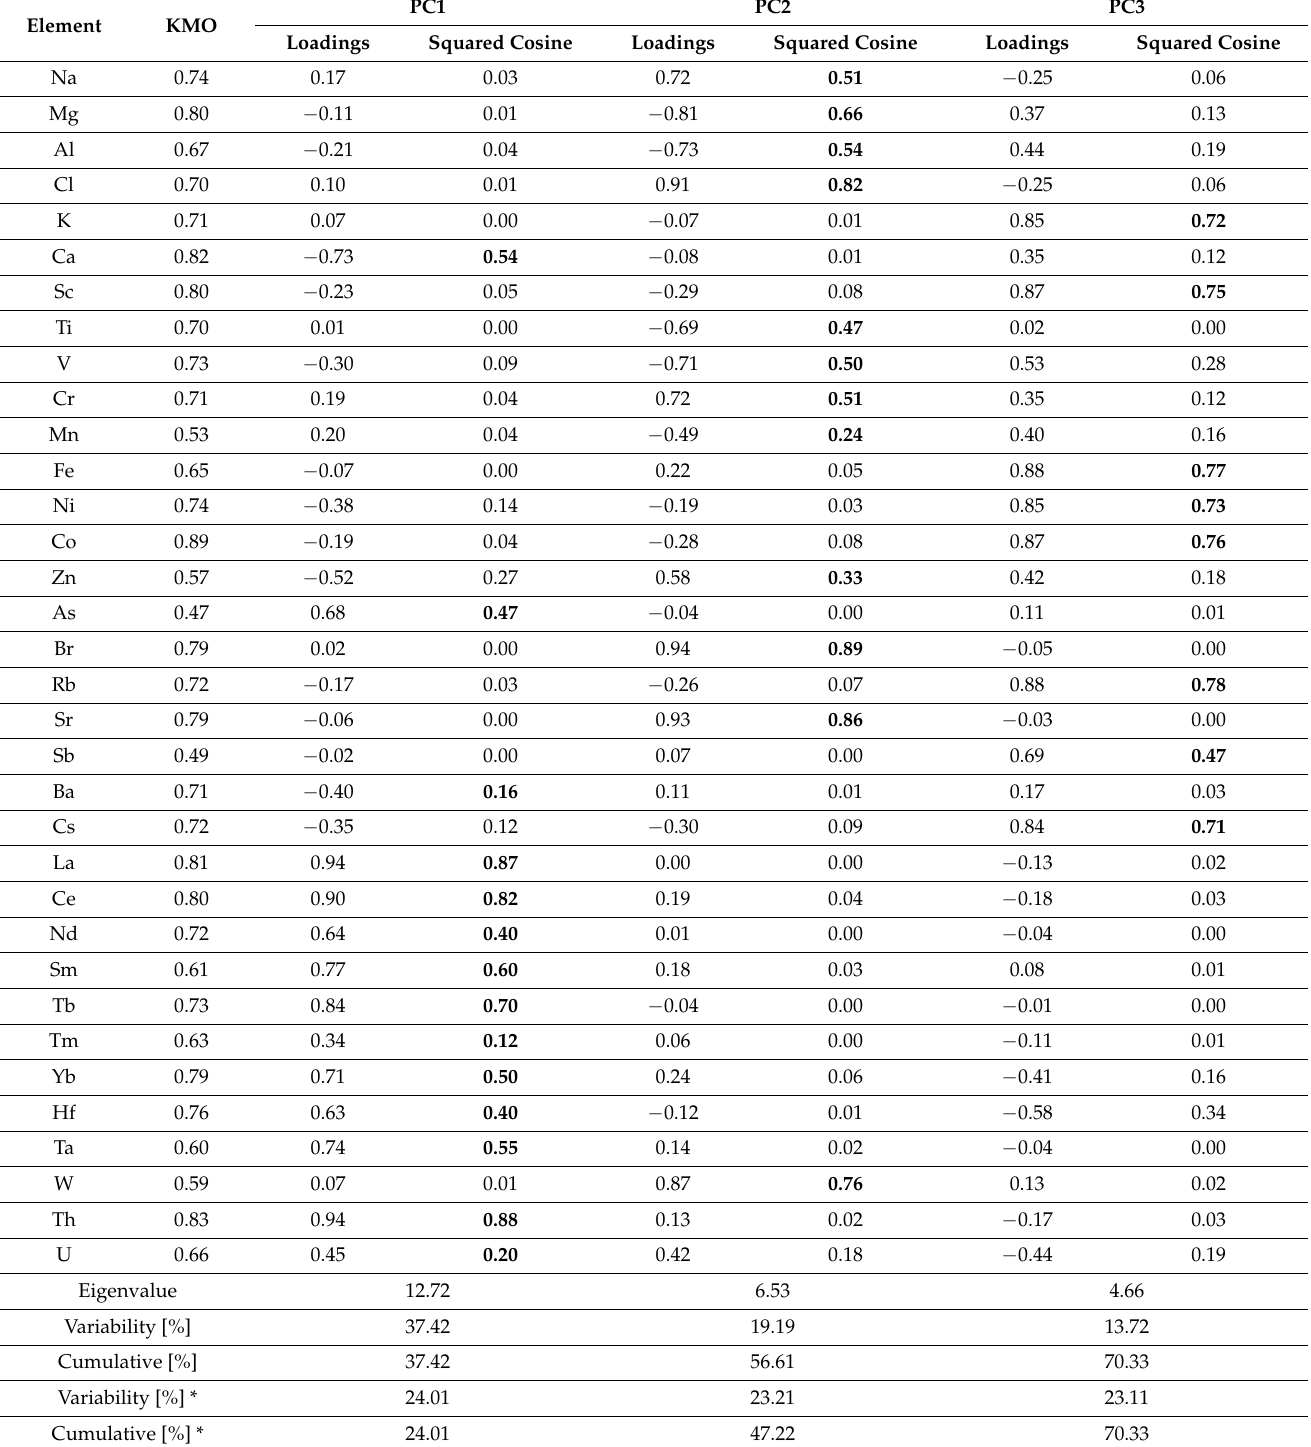
Table 6. Principal component analysis data for the elements quantified in sediment sample of Amara